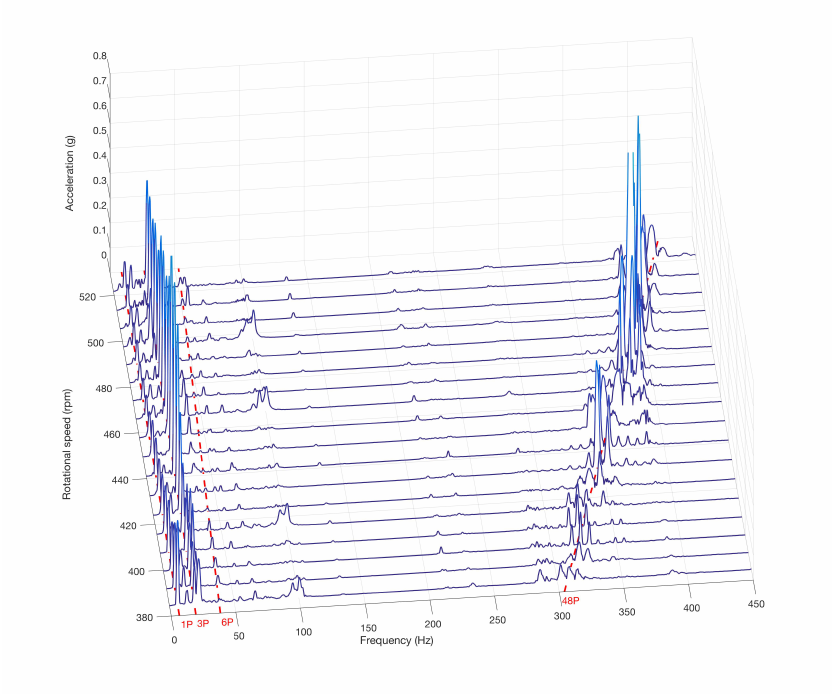
Figure 19. Waterfall of vibration of the tail fin in the Y direction under the ramp wind time